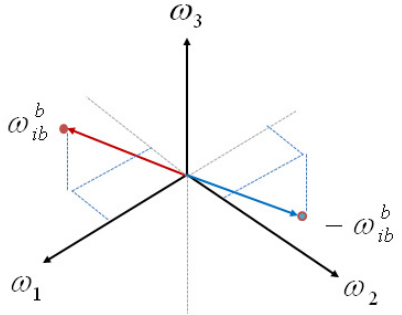
Figure 3. Two possible solutions in angular rate